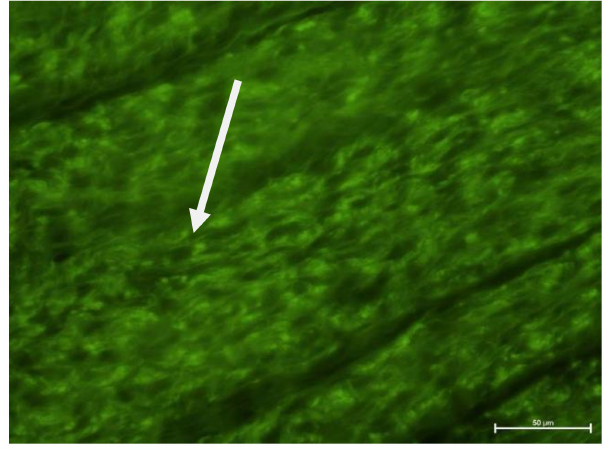
Figure 5. Fluorescence microscope image, human molar tooth—Group I. Visible capillaries that do not contain erythrocytes. UV-2A. Mag. 200 × .